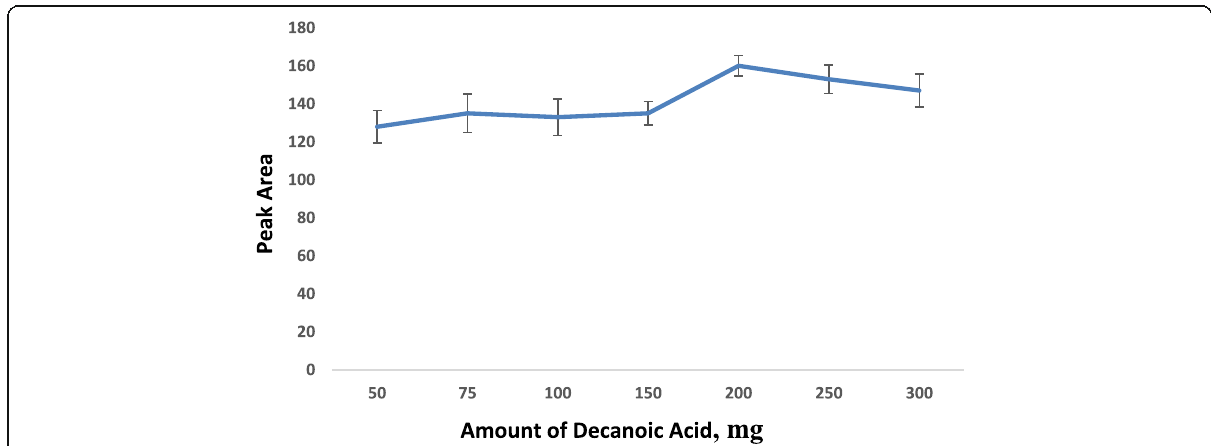
Fig. 3 Effect of DA amount on the extraction efficiency of DKT ( n =